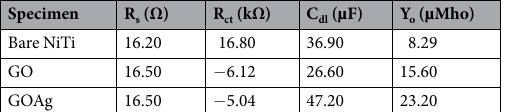
Table 2. Electrochemical impedance spectroscopy parameters of the bare NiTi alloy, GO-coated NiTi (GO), and GO/Ag-coated NiTi (GOAg) substrate. R s = Electrolyte solution resistance, R ct = Charge transfer resistance of the corrosion reaction, C dl = Capacitance, and W = Warburg impedance related to the diffusion of O 2 of the NiTi alloy.